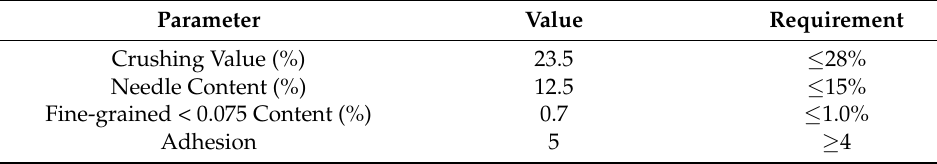
Table 2. Technical indicators of coarse aggregate.